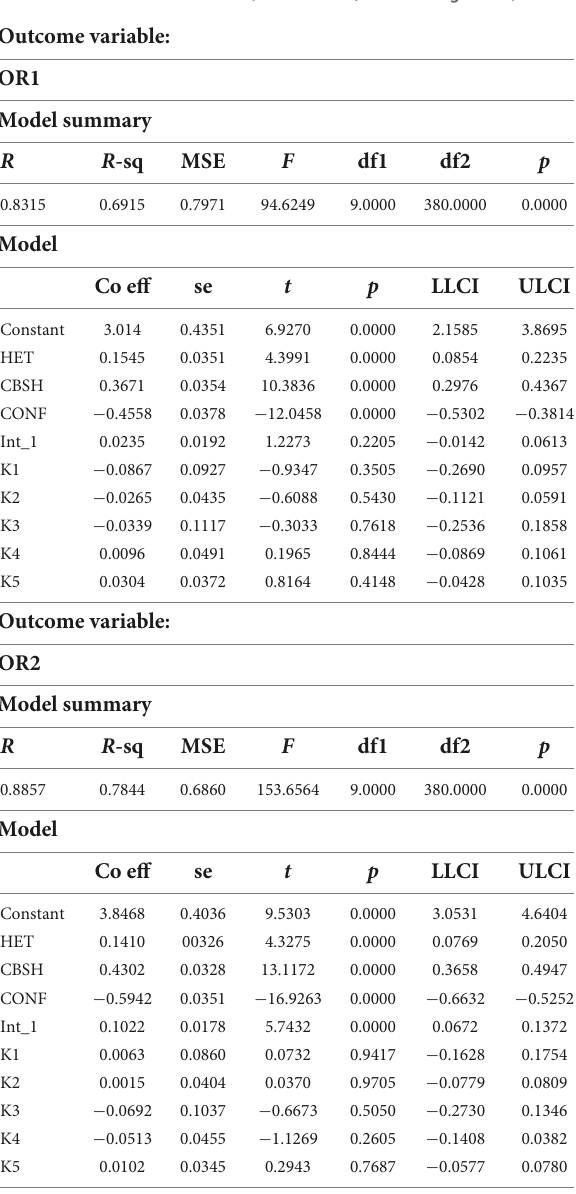
TABLE 4 Table of coefficients (direct effect, moderating